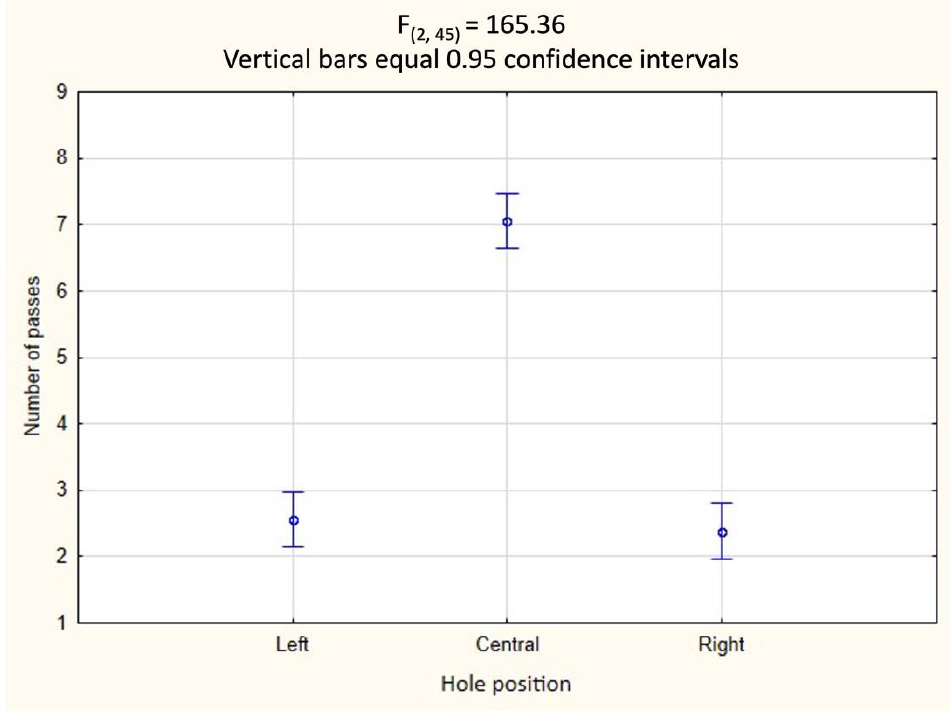
Figure 5. Experiment 1 ( n = 6): differences in the average number of passages through holes depending on their location in the partition; left, center, or right.